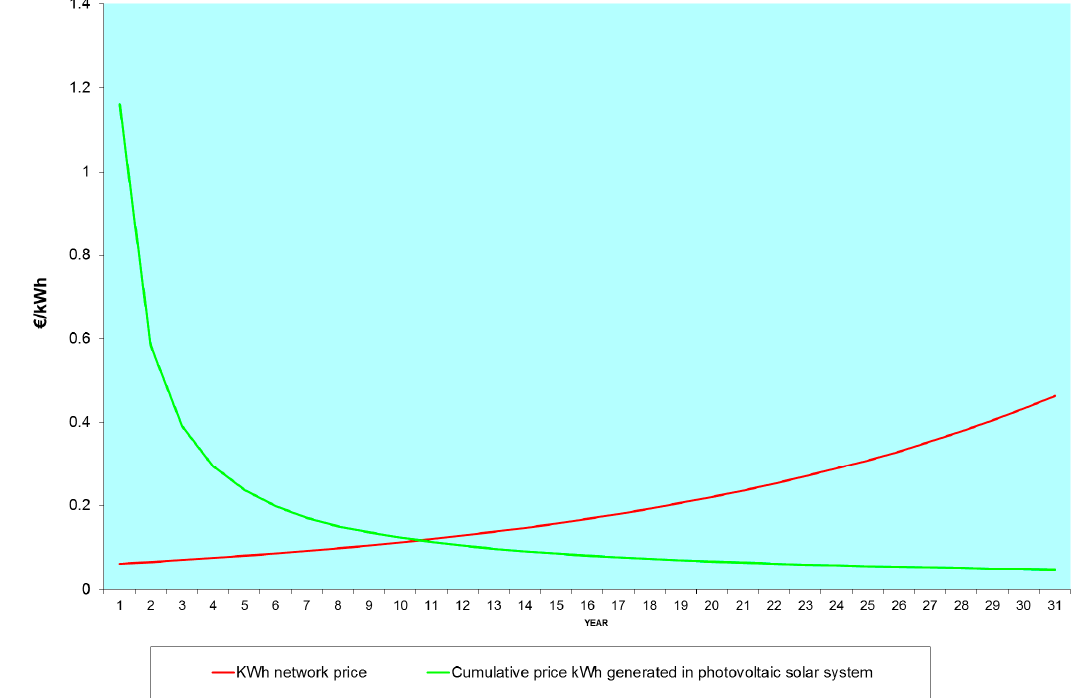
Figure 9. Comparative kWh cost of network versus cost of kWh generated by photovoltaic solar installation. Water well.